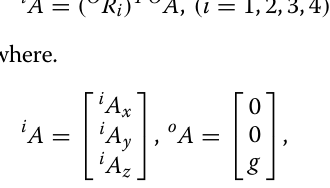
nine-axis motion sensor (SS-WS1792; Sports Sensing Co., Ltd.) used for this study includes a three-axis gyro- scope ( 1500 dps), a three-axis accelerometer ( ± G), and a three-axis magnetometer ( 38 53 11 mm sensor weighs 30 g. × ×